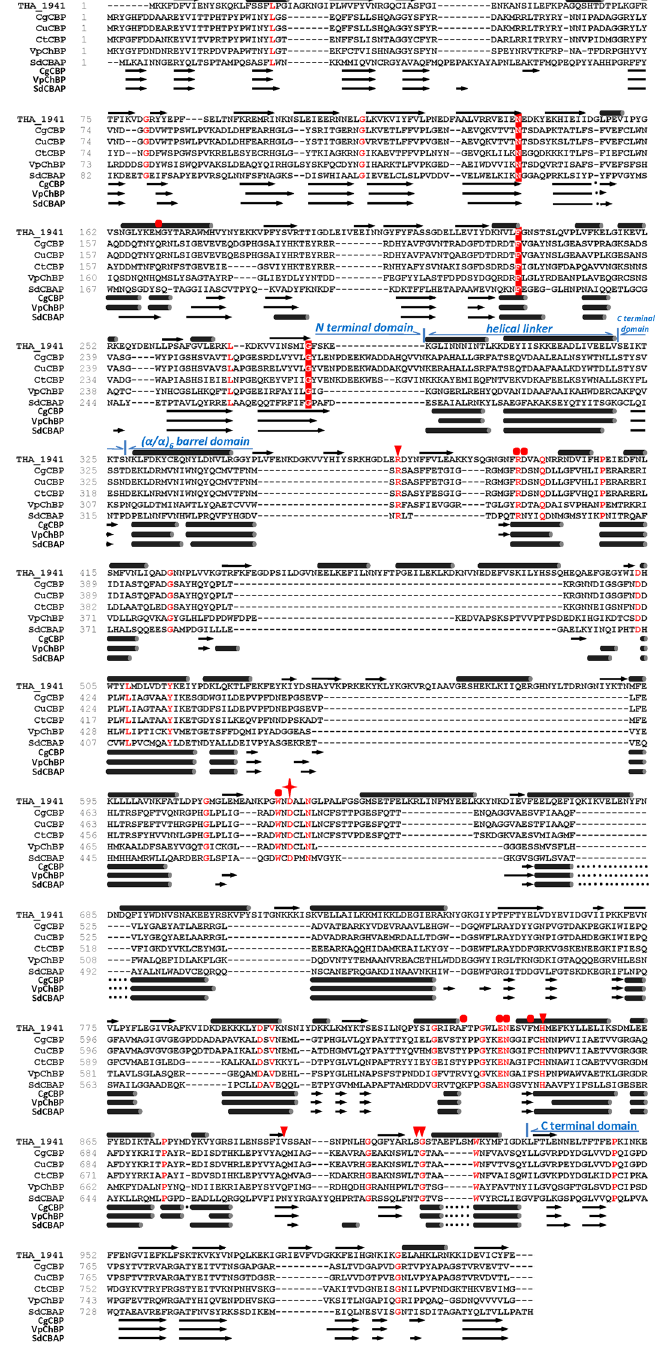
Figure 2. Amino acid sequence alignment of THA_1941 with structure-solved GH94 enzymes. Sequence alignment of THA_1941 with structure-solved CBPs from Cellvibrio gilvus (CgCBP, BAA28631.1), Cellulomonas uda (CuCBP, AAQ20920.1), and Clostridium thermocellum (CtCBP, AAL67138.1), ChBP from Vibrio proteolyticus (VpChBP, BAC87867.1), and CBAP from Saccharophagus degradans (SdCBAP, ABD80168.1) was performed using the program ClustalX2 42 and formatted with BioEdit. Secondary structure was predicted with PSIPRED sever 43 and the secondary structural elements are marked on the top. Secondary structure elements from CgCBP, VpChBP and SdCBAP are shown below the sequence alignment (the secondary structure of CgCBP represents that of CuCBP and CtCBP because of their high similarity). Arrows and columns represent the β strands and α helices, respectively. Conserved residues in the N terminal sandwich domain ( Glyco_trans_36 , PF06165, reclassficated into GH94) are highlighted with red rectangles. The catalytic residues are marked with red stars, while the phosphate binding sites and the sugar binding sites are marked with triangles and dots,